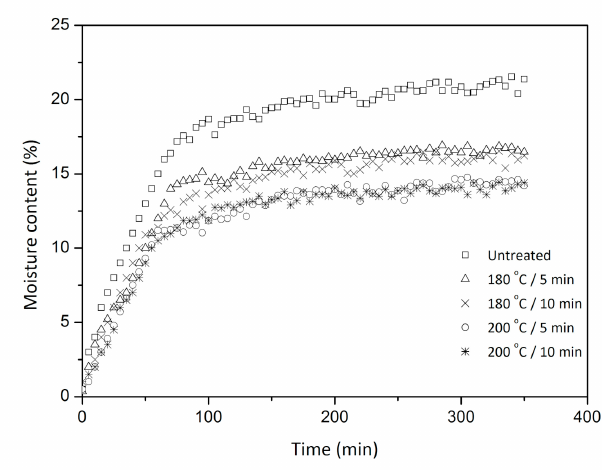
Figure 2. Moisture adsorption of untreated and steam treated pelletized samples in the controlled chamber set at 30 ◦ C and 90% relative